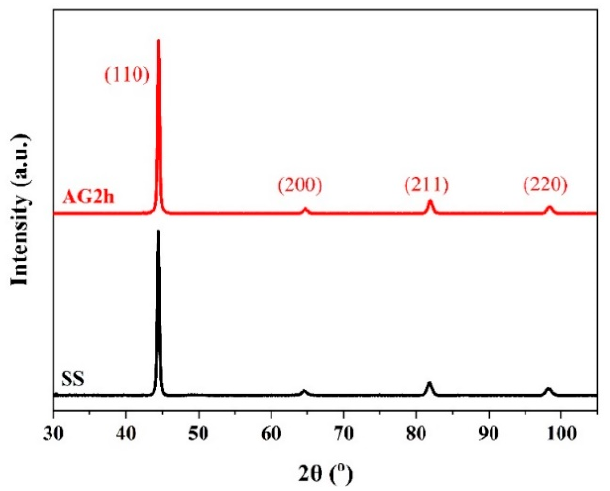
Figure 4. XRD spectrum of the SS and AG2h steels.